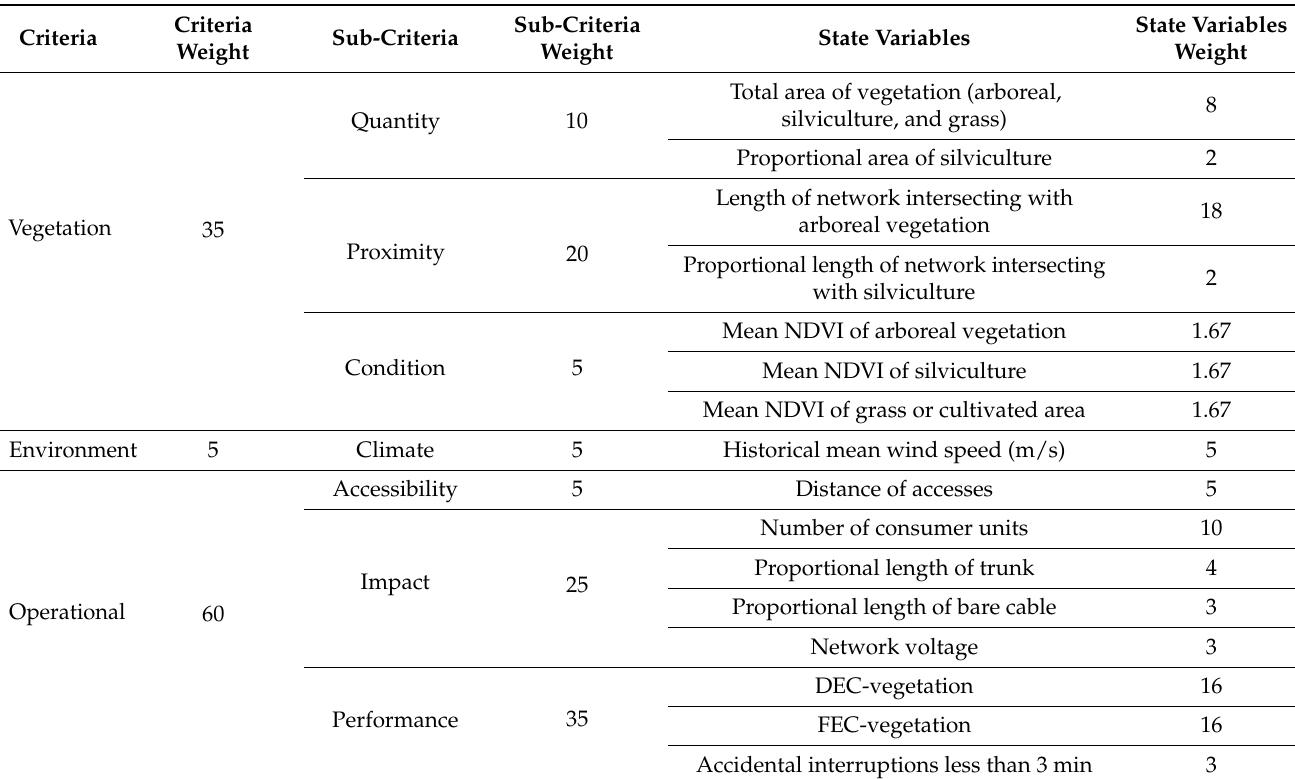
Table 6. Weights used to compute PIVM for rural